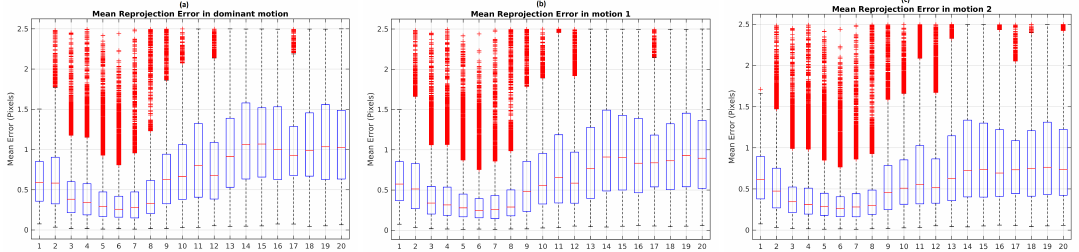
Figure 17. Mean reprojection error results of Monte Carlo test: ( a ) Dominant motion; ( b ) Motion 1; ( c ) Motion 2.